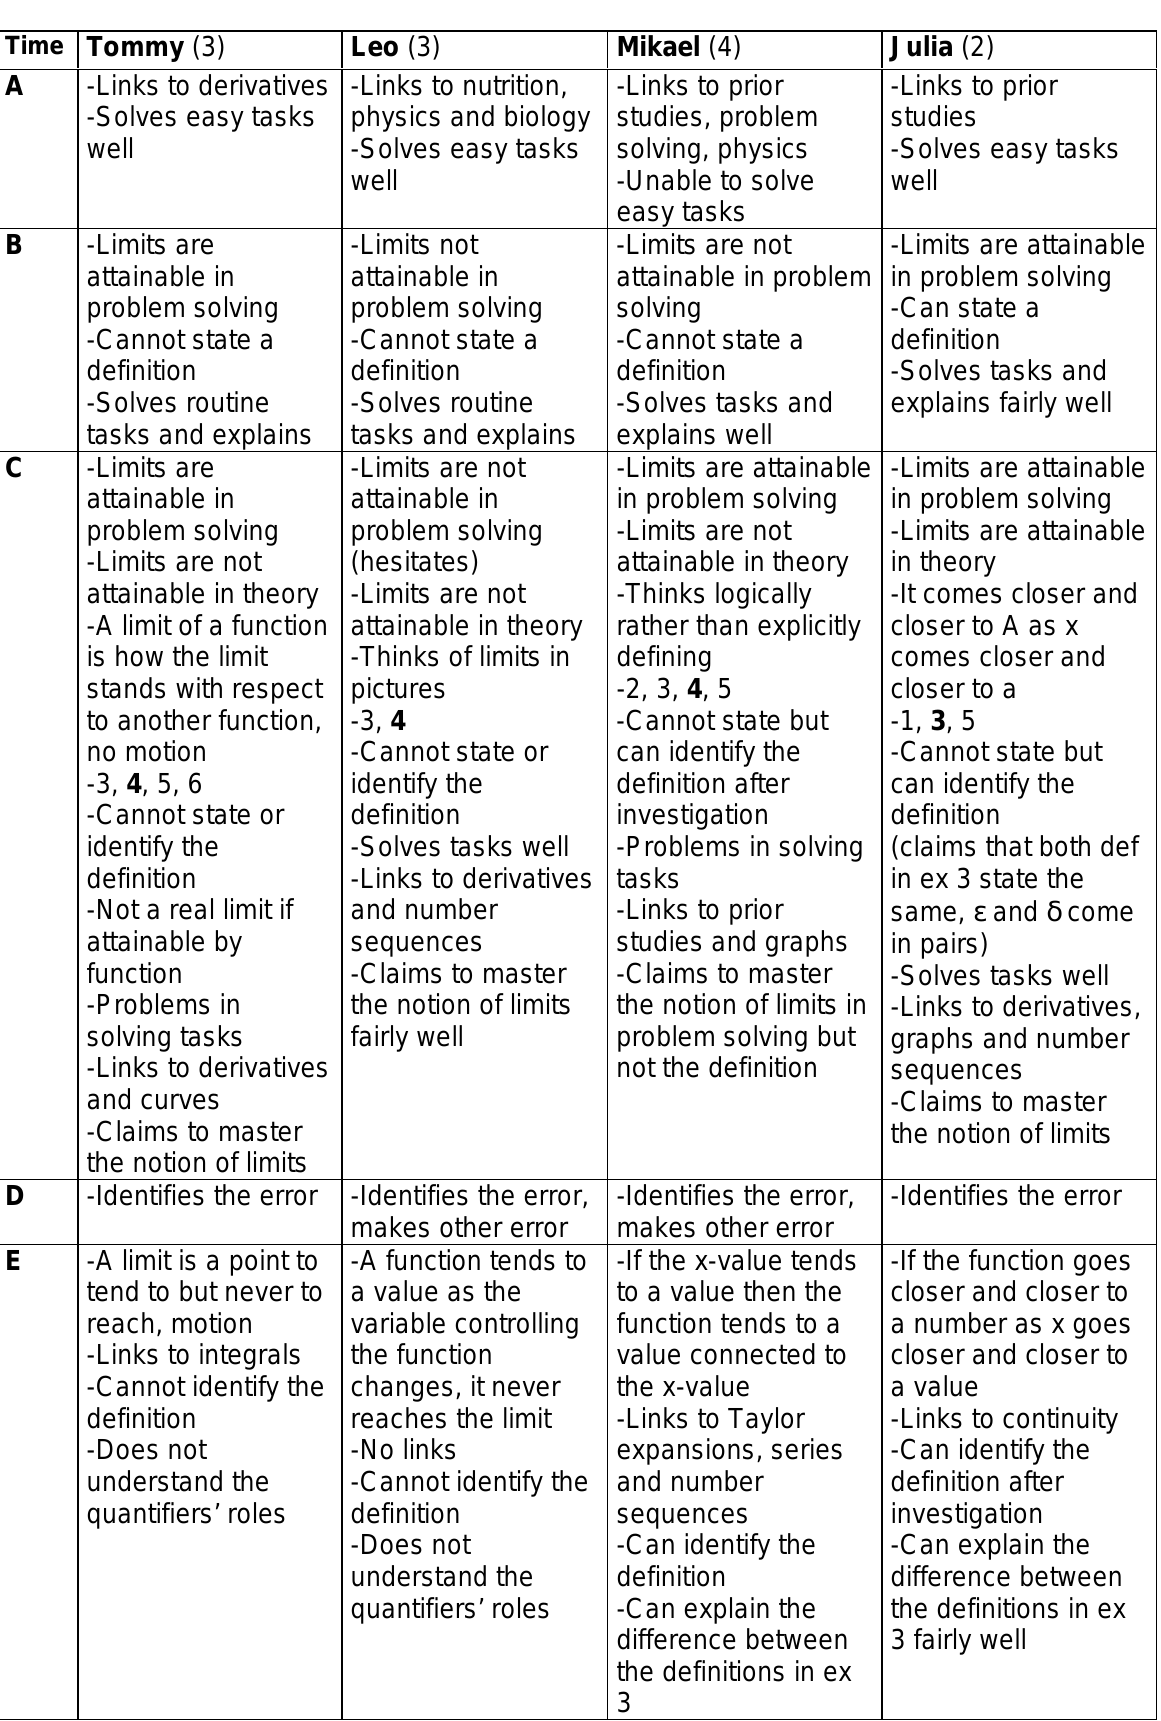
Table 1 . Students’ developments through the